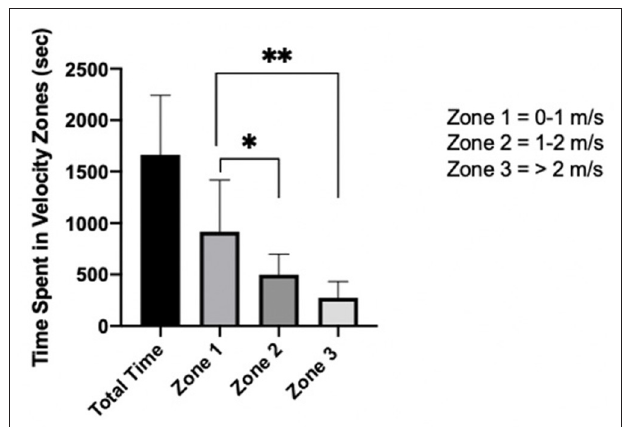
FIGURE 1 | Mean movement time [seconds (sec)] spent in each velocity zone (zone 1–3) throughout a wheelchair rugby game. (*) denotes significance between Zone 1 and Zone 2, whereas (**) denotes significance between Zone 1 and Zone 3.